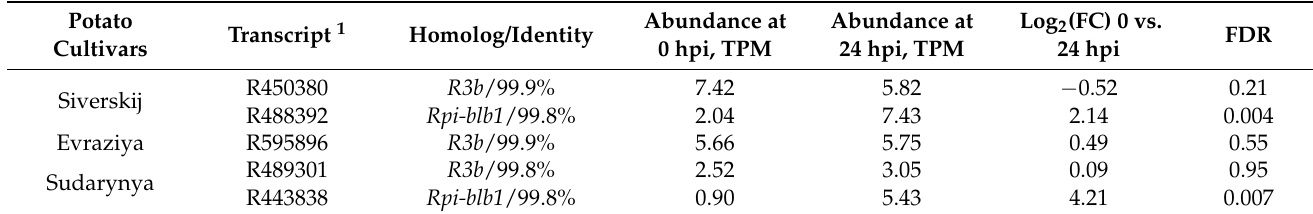
Table 4. Expression of P. infestans resistance genes in the transcriptomes of potato genotypes. Potato